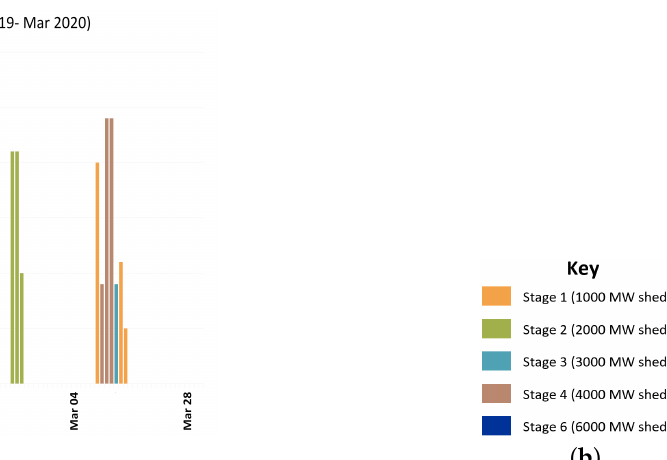
Figure 2. Loadshedding incidents from December 2019 to March 2020 (graph generated from data collated from public announcements issued by the national energy provider, Eskom). ( a ) Outages from December 2019 to March 2020; ( b ) Key for implemented loadshedding stages.